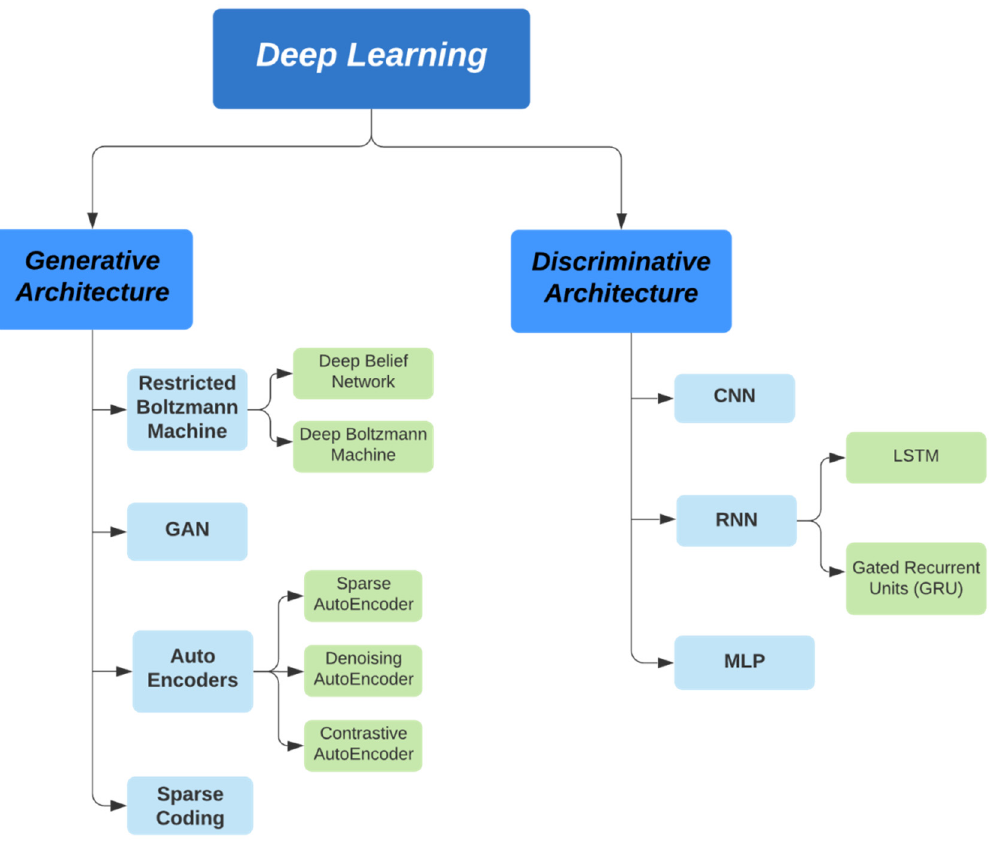
Figure 5. Nomenclature of current deep learning models for electronic information security.